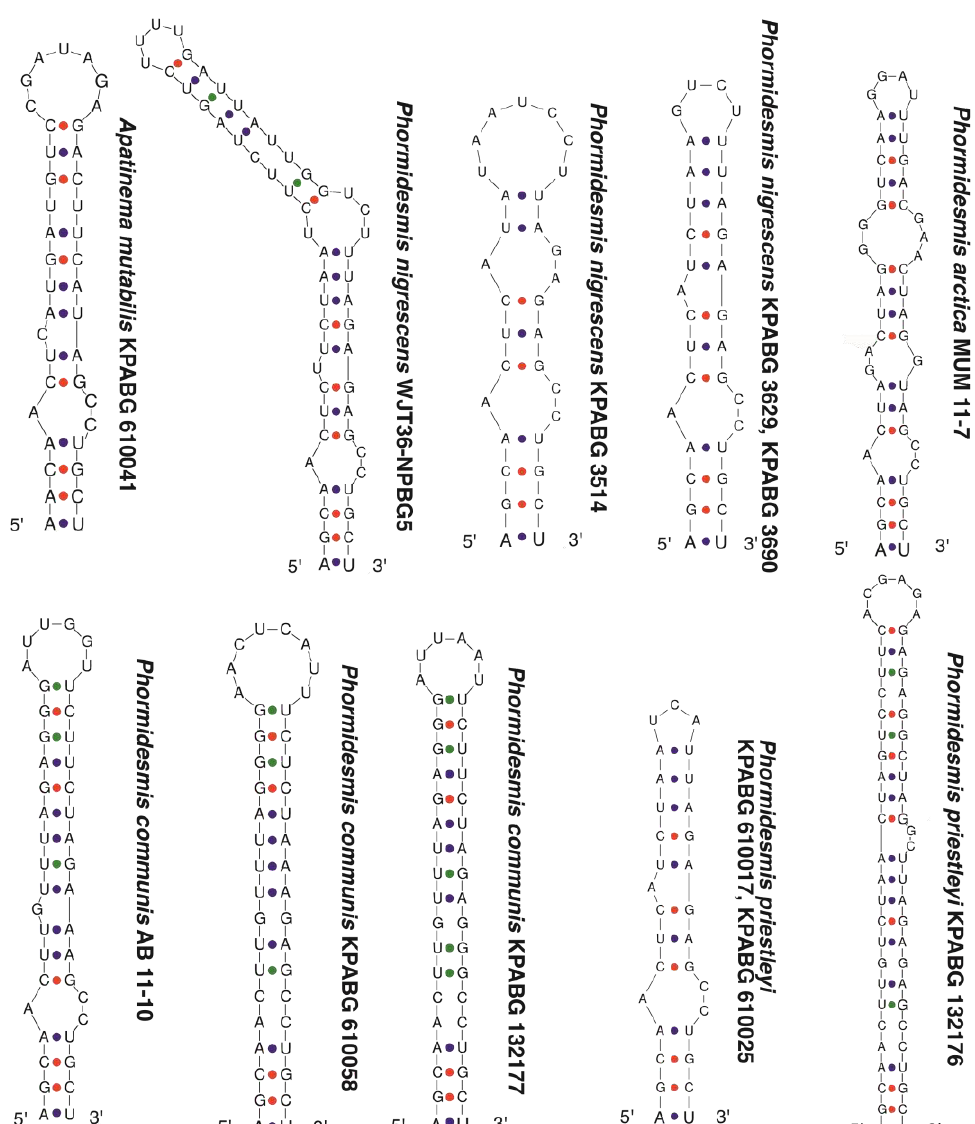
Figure 5. Secondary structure of the Box-B helix of the 16S – 23S ITS region.